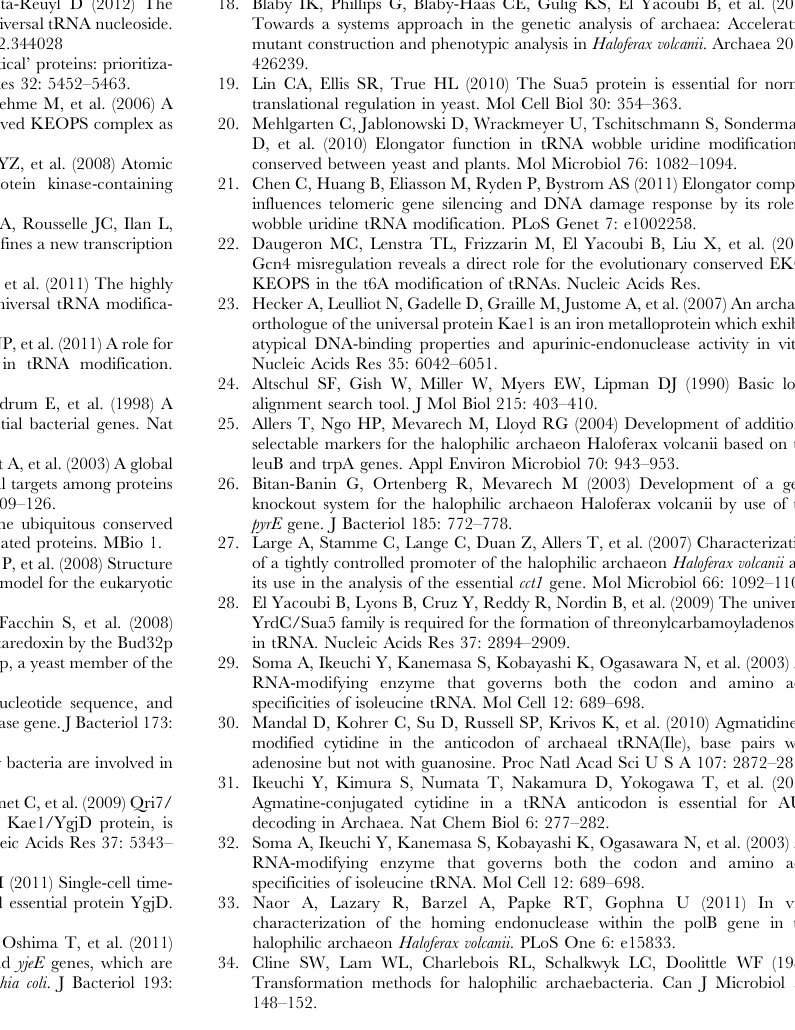
Figure S1 Confirmation of genetic mutations. Oligonucleotides anneal outside of the open reading frame, but within the region of homology used for ‘‘pop-in/pop-out’’ deletions. A. PCR analysis of kae1-bud31 fusion using primers AP26 and AP27. Lane 1 - DNA ladder, lane 2 - wild type. Lane 3- the ‘‘pop in’’ strain (HAN1). Lane 4 – ‘‘pop out’’ of kae1-bud32 with kae1-bud32 supplied in trans (HAN4). B. PCR analysis of cgi121 using primers AP229 and